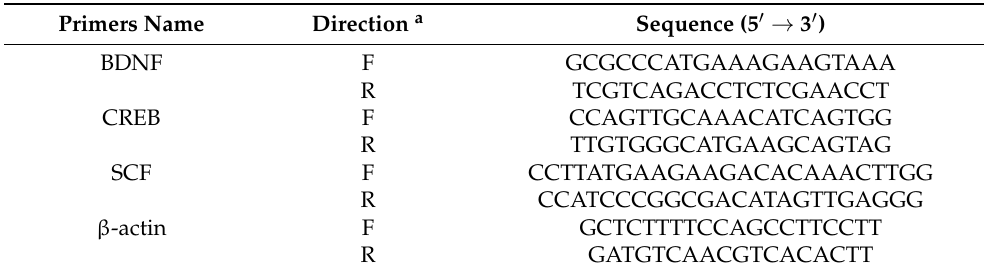
Table 2. Sequences of the primers used for RT-qPCR. a F = forward; R =